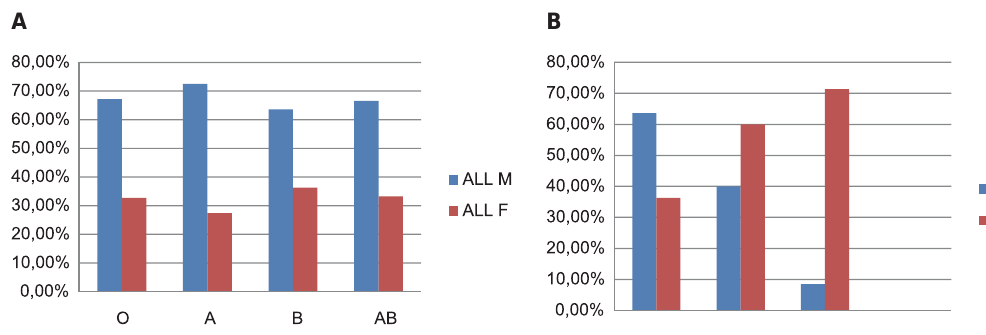
FIGURE 2. Distribution of blood types in ALL (A) and AML (B) based on gender.